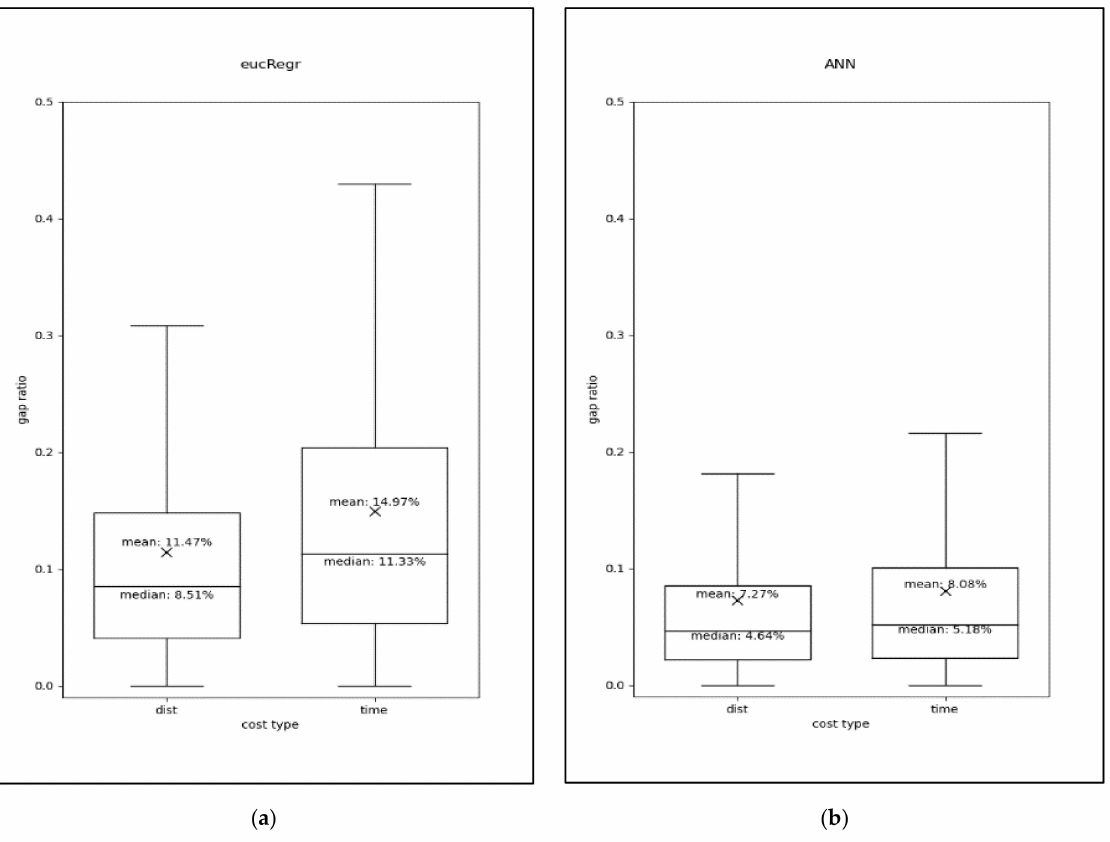
Figure 4. Absolute Percentage error of estimation in box whisker plot. ( a ) Regression model. ( b ) Arti- ficial neural network